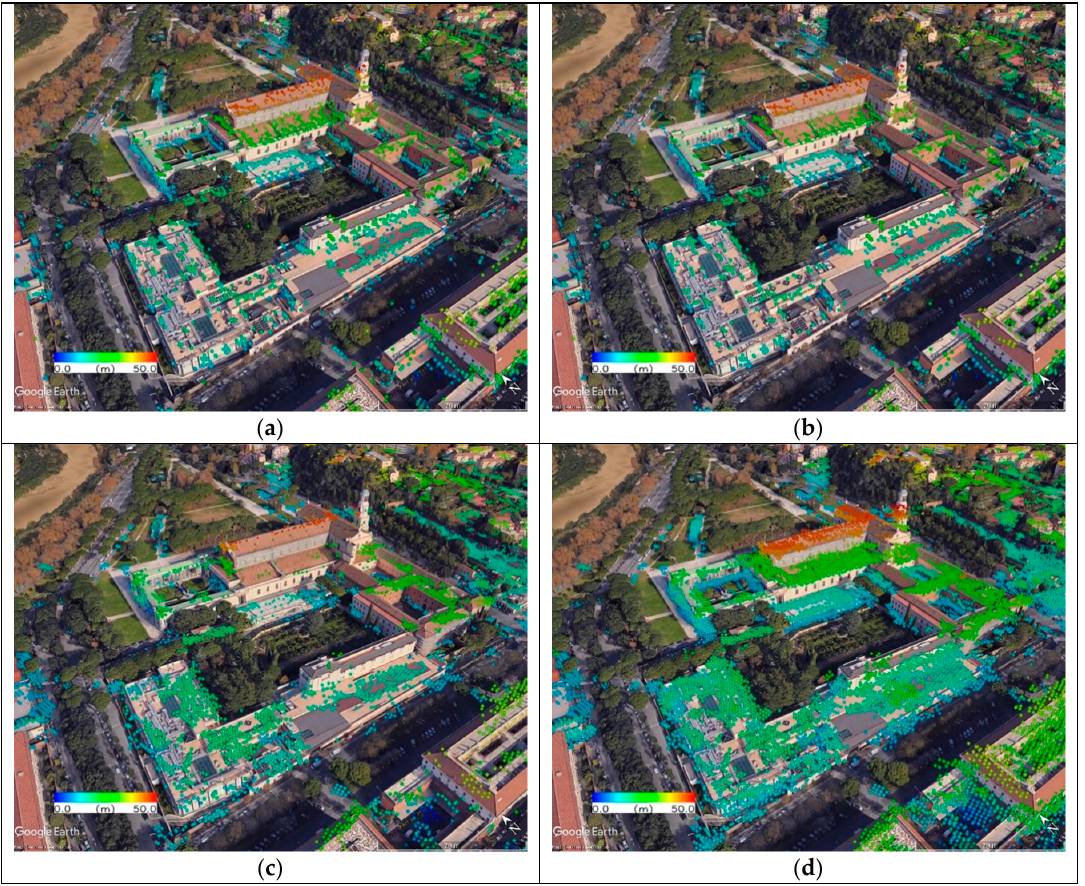
Figure 9 Geocoded scatterers detected on Rome dataset for the single-look (a,b) and multi-look (c,d) Figure 9. Geocoded scatterers detected on Rome dataset for the single-look ( a , b ) and multi-look ( c , d ) cases for the single scatterers (a,c) and both single and double scatterers (b,d). cases for the single scatterers ( a , c ) and both single and double scatterers ( b , d